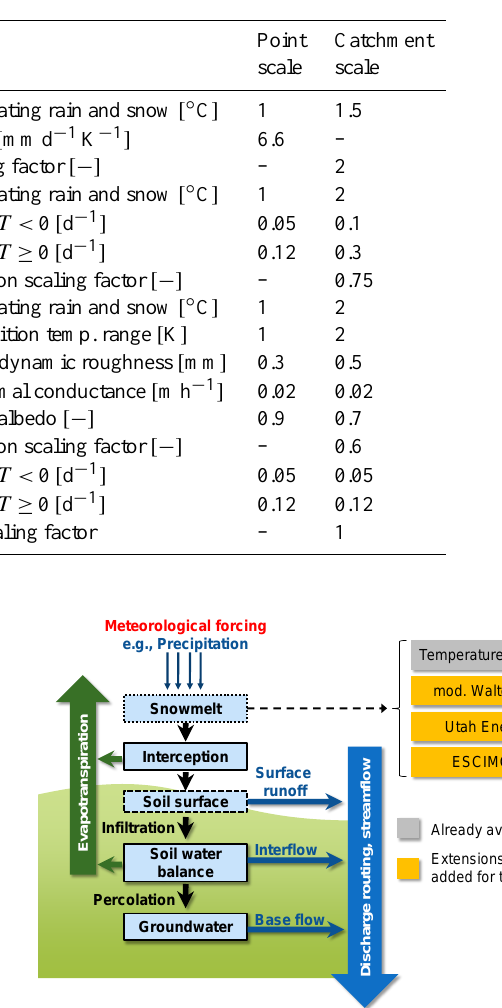
Figure 3. Conceptualization of hydrological processes in the hy- drological modeling system PANTA RHEI (adapted from LWI- HYWAG and IfW, 2012). According to Sect. 2.4, the snowmelt pro- cess can be simulated by four different